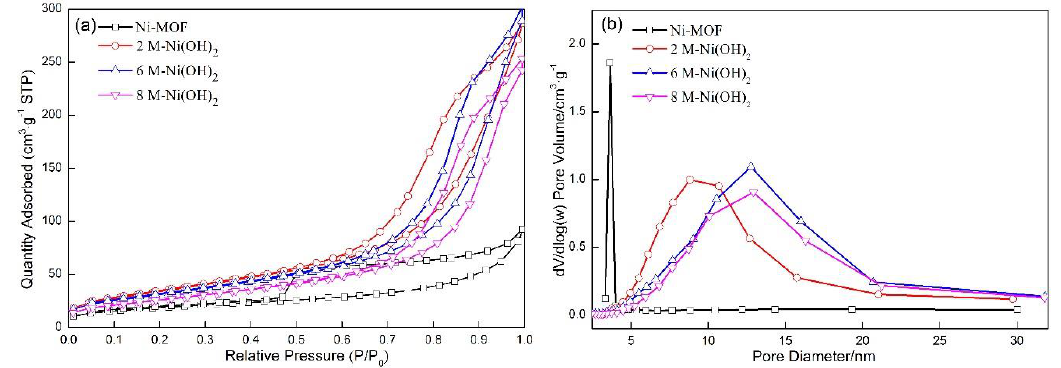
Figure 3. ( a ) N 2 adsorption–desorption isotherm of the Ni-MOF and Ni(OH) 2 , ( b ) the corresponding pore size distribution curves of Ni-MOF and Ni(OH) 2 . Table 1. Pore size and specific surface areas of the Ni-MOF and Ni(OH) 2.